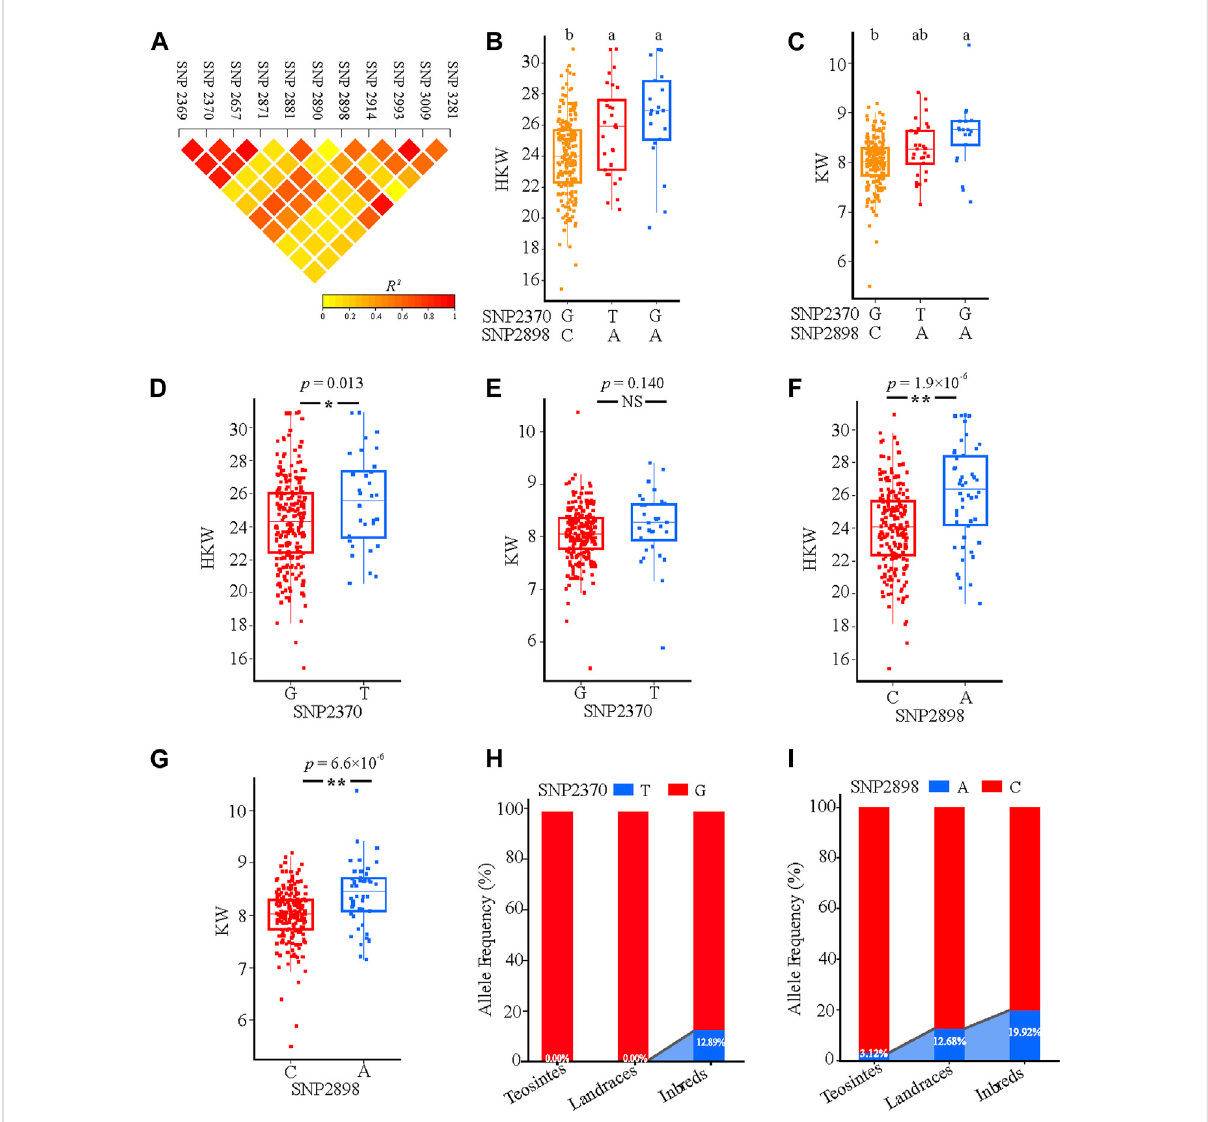
FIGURE 6 Natural variationsin ZmFWL7 were signi fi cantly associated with hundred kernel weight (HKW) and kernel width (KW). (A) Linkage disequilibrium (LD) heatmap for eleven signi fi cant variants associated with ear traits. (B,C) Haplotypes of ZmFWL7 among natural variations based on two nonsynonymous mutation SNP2370 and SNP2898. Different letters indicate signi fi cant difference (Tukey ’ s HSD test at p < 0.05). (D – G) Comparison of hundred kernel weight (HKW) and kernel width (KW) between different alleles of SNP2370 and SNP2898. (H,I) The allele frequencies of SNP2370andSNP2898ininbredlines,landraces,andteosintes. p valueforthe t testcomparingtwogroupscarryingdifferentalleleswereindexedon the top (** p < 0.01; * p <